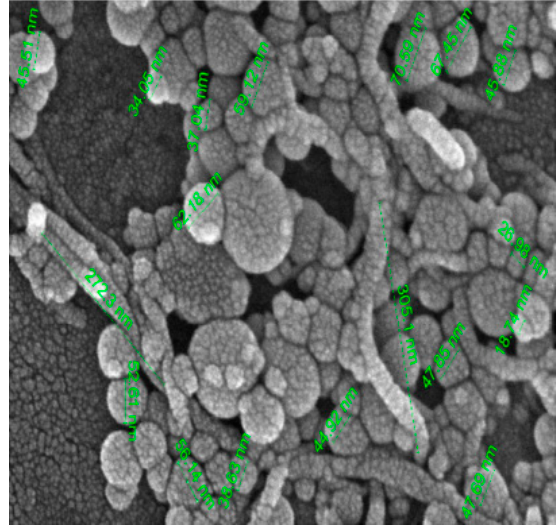
Figure 3. SEM image of Al 2 O 3 –MWCNT/water hybrid nanofluid